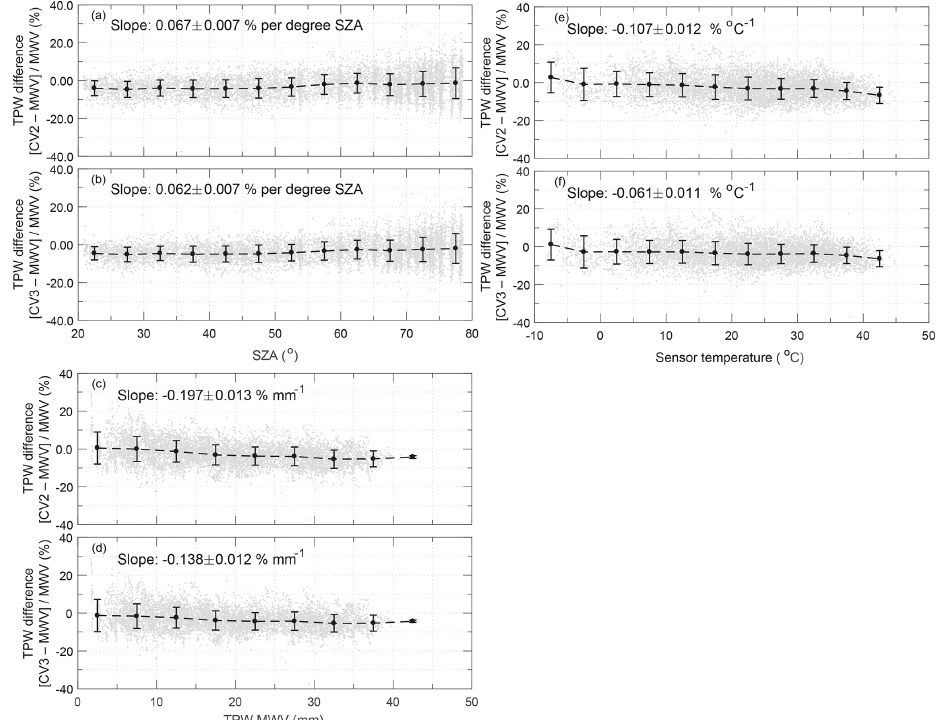
Figure 15. Dependence plot of the relative difference of the TPW from Cimel sun photometer and the radiometer from the SZA (a) for Cimel V2 and (b) Cimel V3. The relative difference between (c) Cimel V2 and (d) Cimel V3 as a function of TPW and the internal sensor temperature for (e) V2 and (f) V3. The black dots show the average difference in bins of 5 ◦ , 5mm and 5 ◦ C and the error bar represents the standard deviation of the